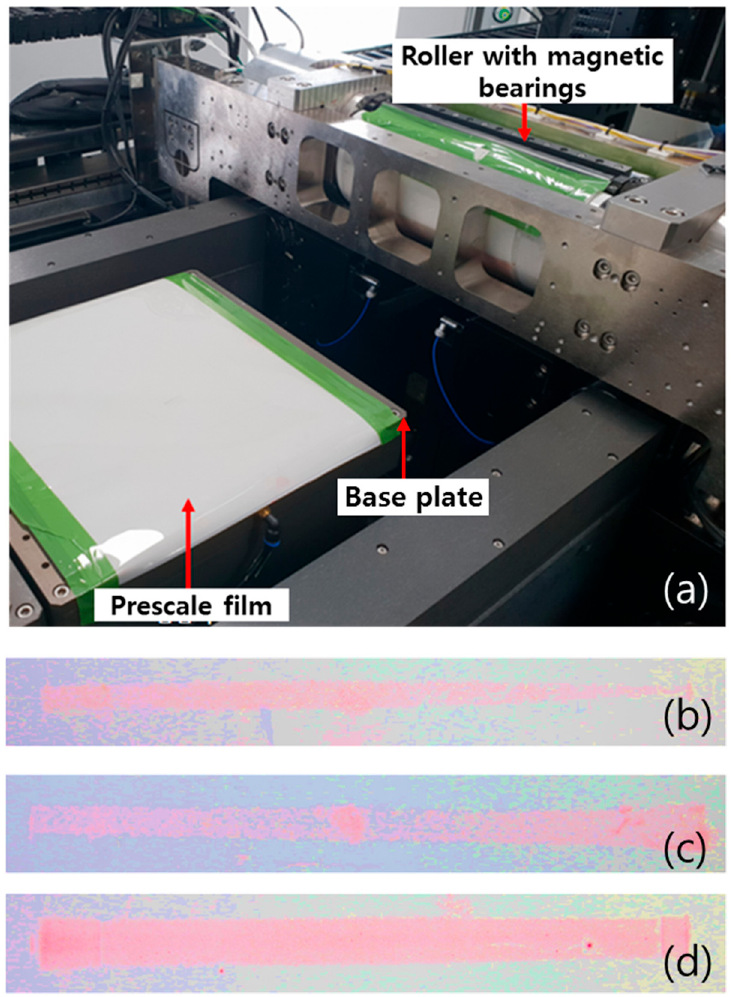
Figure 17. ( a ) Experimental setup and test results of force distribution ( b ) before and ( c ), ( d ) after roller alignment.